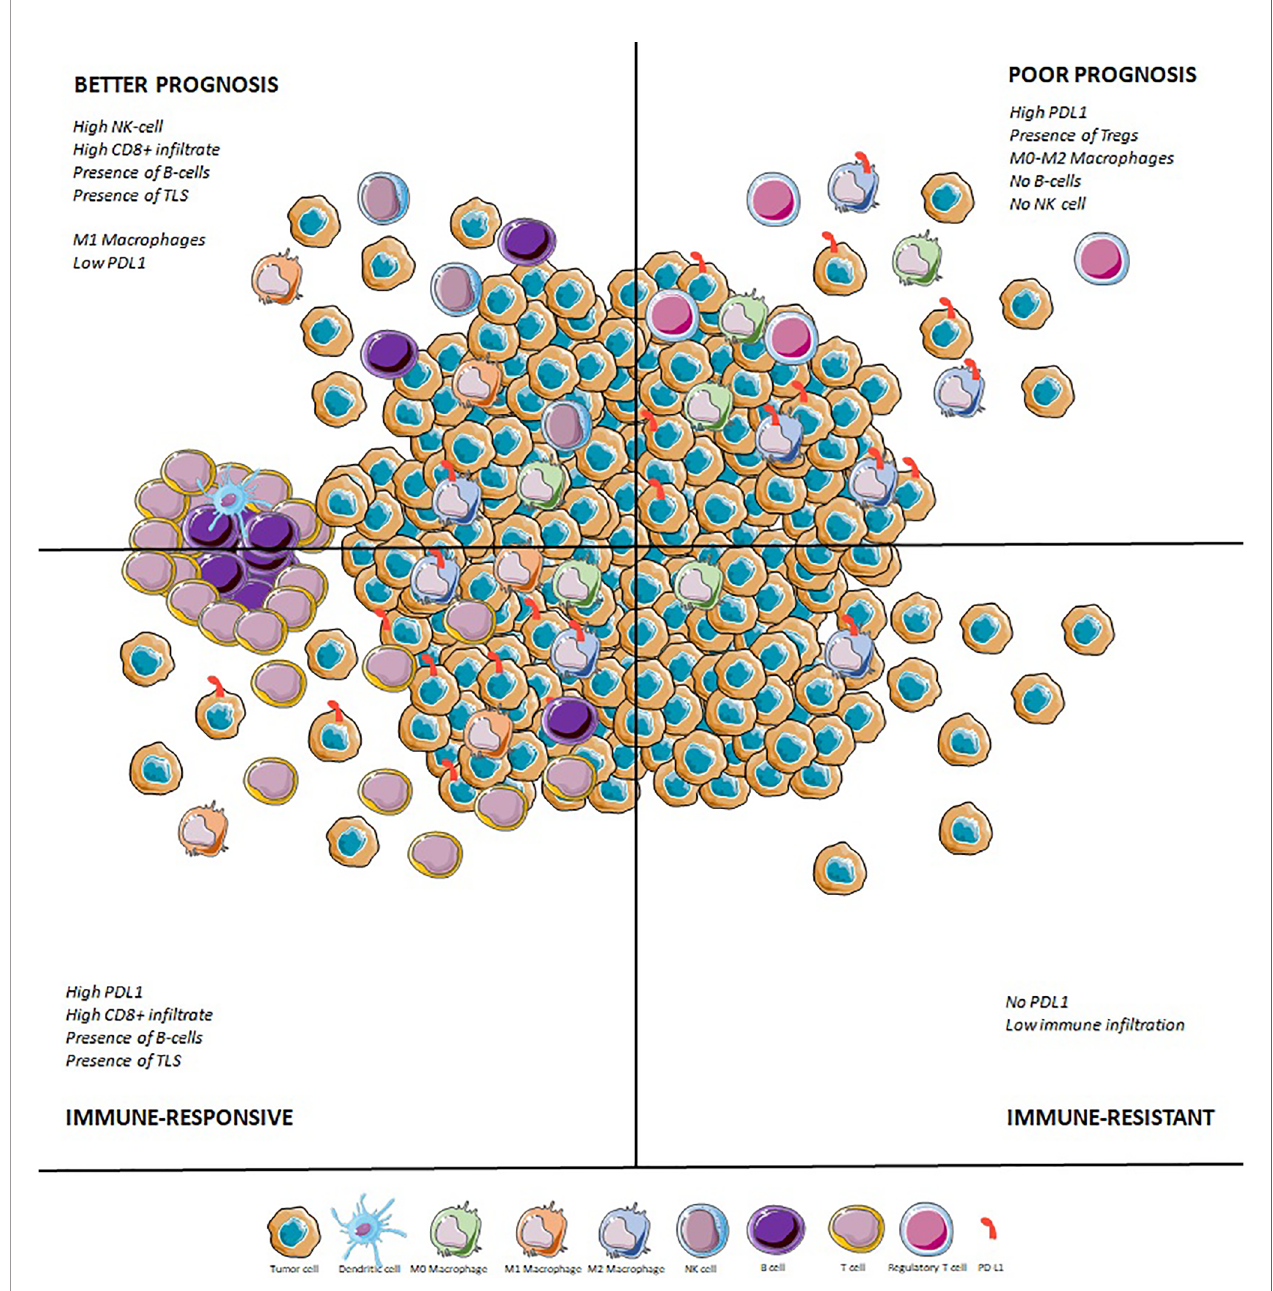
FIGURE 2 | Immune tumor microenvironment in sarcomas: prognostic and predictive impact. TLS, Tertiary lymphoid structures; TMB, Tumor mutational burden